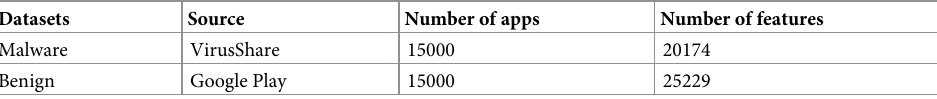
Table 2. The details of the